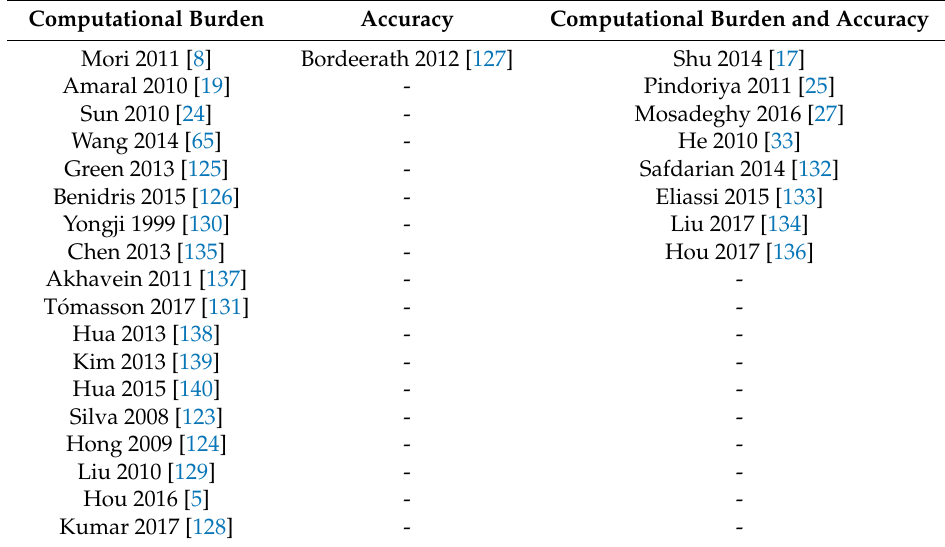
Table 1. Categorization of articles in the evaluation efficiency subcategory according to the main